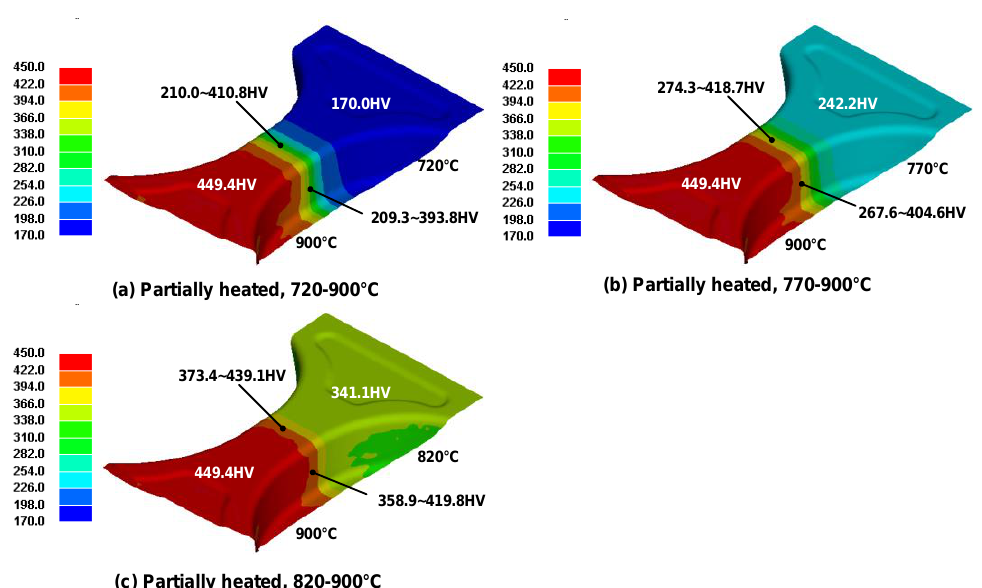
Figure 9. Predicted hardness distribution of the lab-scale center pillar.